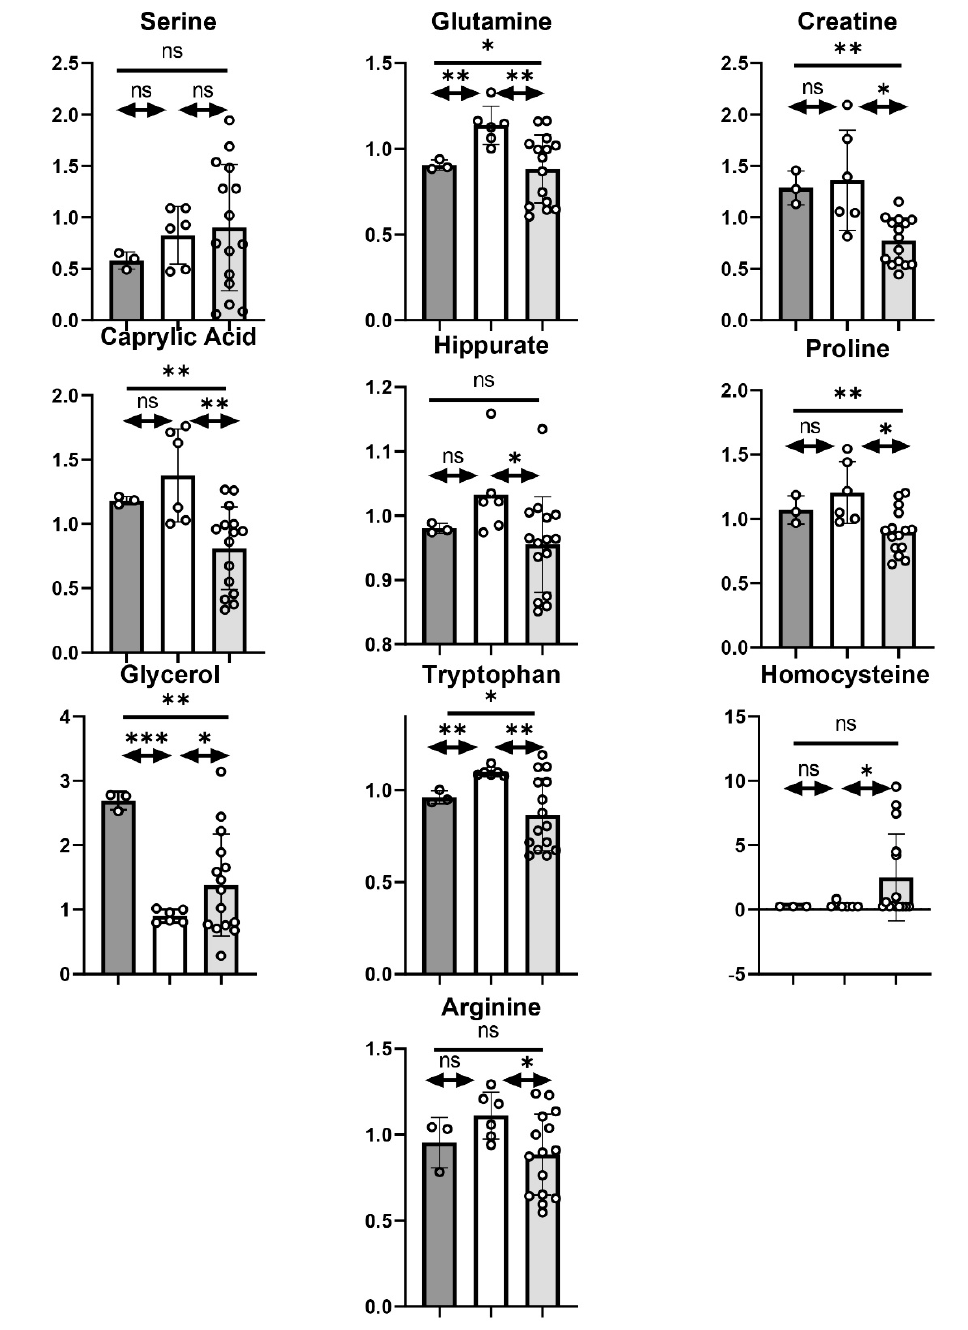
Figure 7. Extracellular LR PPOL and HR IPPOL keratinocyte metabolites distinguishing between PPOL and OSCC in saliva samples in vivo. The bar charts show selected metabolites from the unbiased metabolic screen that have been reported to be associated with PPOL progression in saliva samples in vivo, and which show similar trends distinguishing between LR MPPOL, HR IPPOL, and normal oral keratinocytes in vitro. The data are the results of three independent experiments +/ − standard deviation derived from one line of healthy normal keratinocytes, two lines of LR MPPOL keratinocytes, and five lines of HR IPPOL keratinocytes. The data are not normalised for cell number or protein, but are from cultures of equal surface area. The data are presented as scaled intensity/mL of conditioned medium. Dark grey bars = normal oral keratinocytes; white bars = LR PPOL keratinocytes; and light grey bars = HR IPPOL keratinocytes. Significant by one-way ANOVA (bar) or Welch’s Test (arrowed lines) * p < 0.05; ** p < 0.01; and ***; p < 0.001.